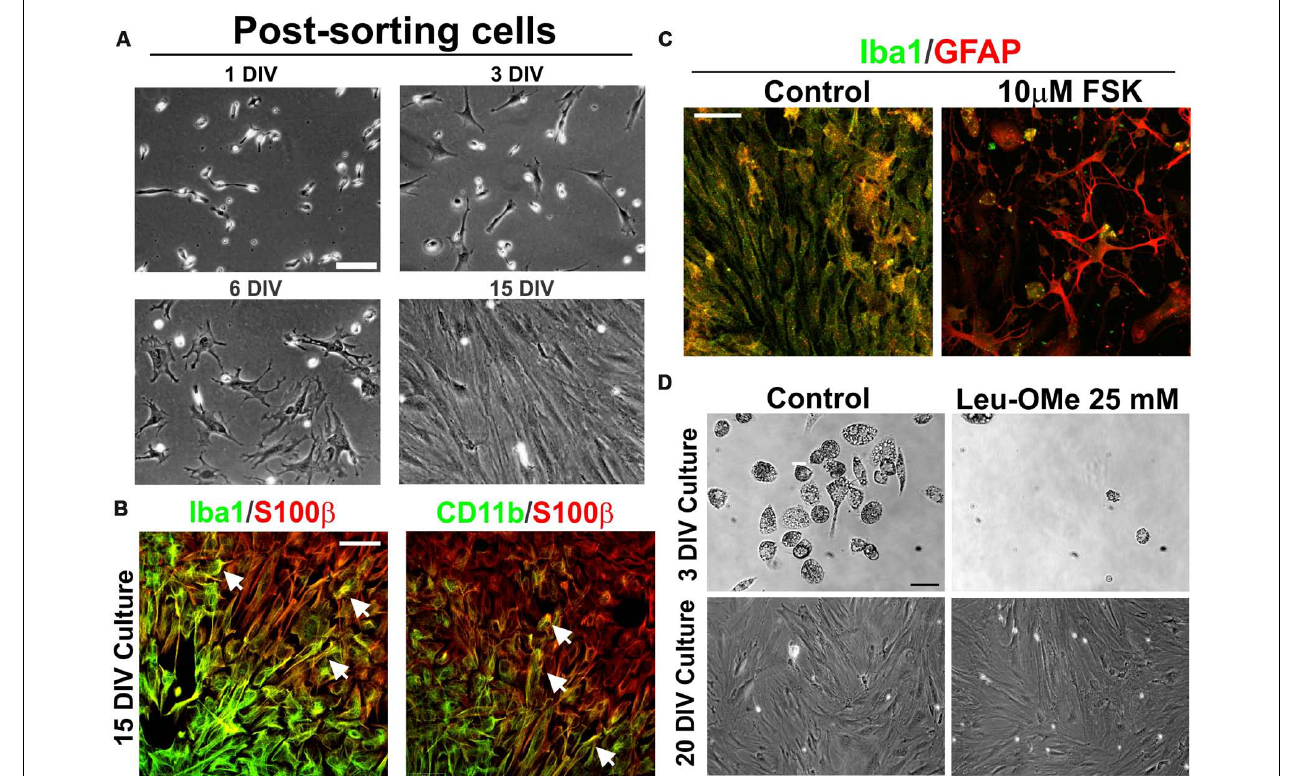
FIGURE 4 | Phenotypic transition of microglia intoAbA cells in culture. (A) Microglia cell cultures (7 DIV) from symptomatic spinal cord were dissociated and stained with FITC-labeled CD11b. After FACS sorting, cells were re-plated and analyzed for phenotypic transition at DIV15. Scale bar: 50 μ m. (B) Confocal image showing transition zones observed at 15 DIV. Note the segregation of astrocytic S100 β staining with the microglia Iba1 or CD11b markers, which coincides with the morphological change of cells.The co-localization of astrocytic and microglia markers was found in a few cells in